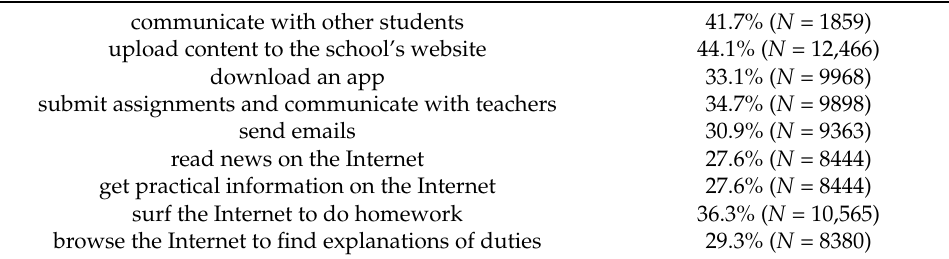
Table 1. Description of the actions related to the use of